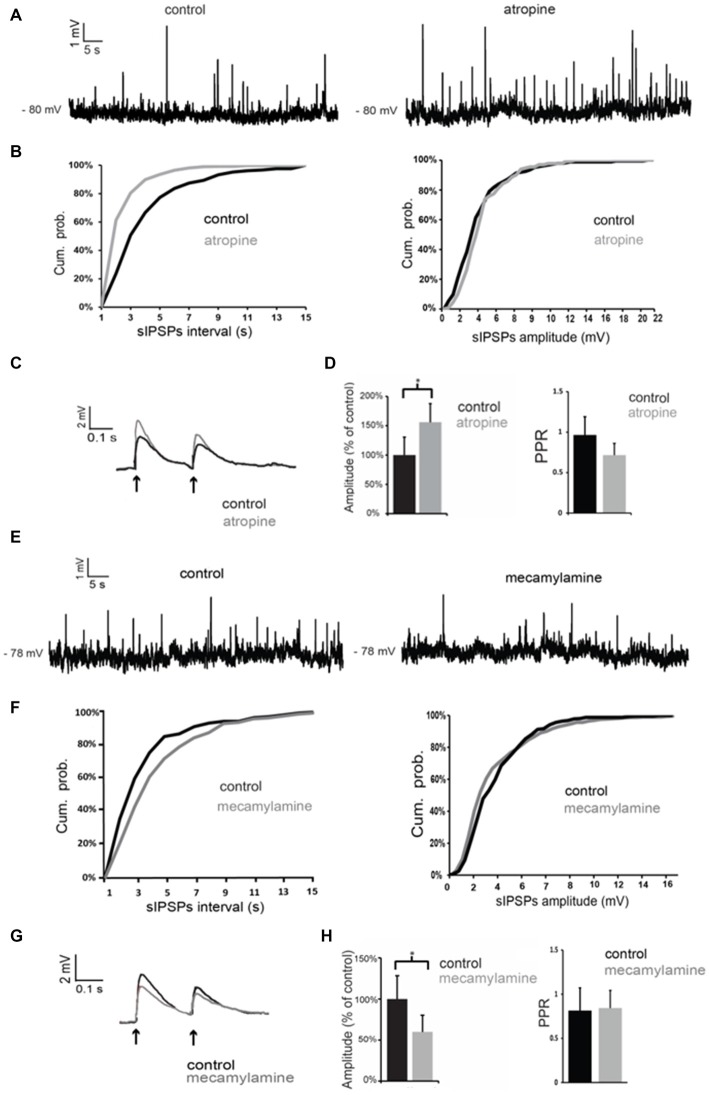
Nicotinic and muscarinic antagonists affect GABAergic inputs to LTS interneurons. (A) Atropine increased the frequency of spontaneous GABAergic events in a LTS interneuron. (B) Quantification of the effects of atropine on frequency and amplitude of spontaneous GABAergic events in the interneuron of (A). The frequency, but not the amplitude, of spontaneous inhibitory postsynaptic potentials (IPSPs) was significantly (p < 0.05 for inter-event intervals) increased by atropine. (C) The amplitude of evoked GABAergic PSPs was significantly increased by atropine in a LTS interneuron. Traces are average of five consecutive events evoked by paired-pulse stimulation (200 ms intervals) delivered every 10 s. (D) Average effects of atropine on the amplitude of the first evoked GABAergic PSP and on Paired-pulse ratios (PPR). For each experiment, the amplitude of GABA responses in the presence of atropine was expressed as percentage of average GABA response amplitude in control solution. Asterisk indicates statistical significance at p < 0.05. (E) Mecamylamine decreased the frequency of spontaneous GABAergic events in a LTS interneuron. (F) Quantification of the effects of mecamylamine on frequency and amplitude of spontaneous GABAergic events in the interneuron of (A). The frequency, but not the amplitude, of spontaneous IPSPs was significantly (p < 0.05 for inter-event intervals) decreased by mecamylamine. (G) The amplitude of evoked GABAergic PSPs was significantly decreased by mecamylamine in a LTS interneuron. Traces are average of five consecutive events evoked by paired-pulse stimulation (200 ms intervals) delivered every 10 s. (H) Average effects of mecamylamine on the amplitude of the first evoked GABAergic PSP and on PPR. For each experiment, the amplitude of GABA responses in the presence of mecamylamine was expressed as percentage of average GABA response amplitude in control solution. Asterisk indicates statistical significance at p < 0.05.